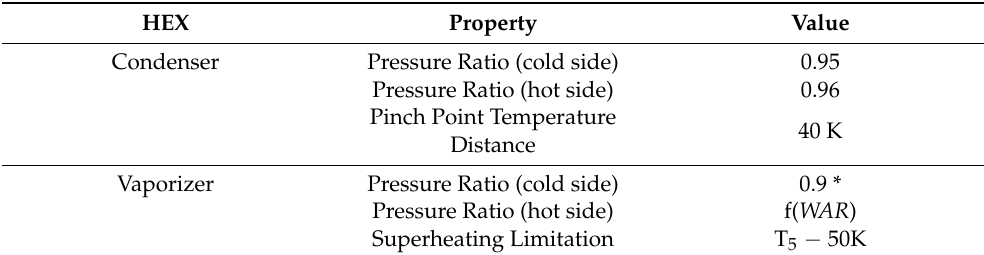
Table 1. Summary of key assumptions taken for the initial estimation of HEX properties within the water treatment